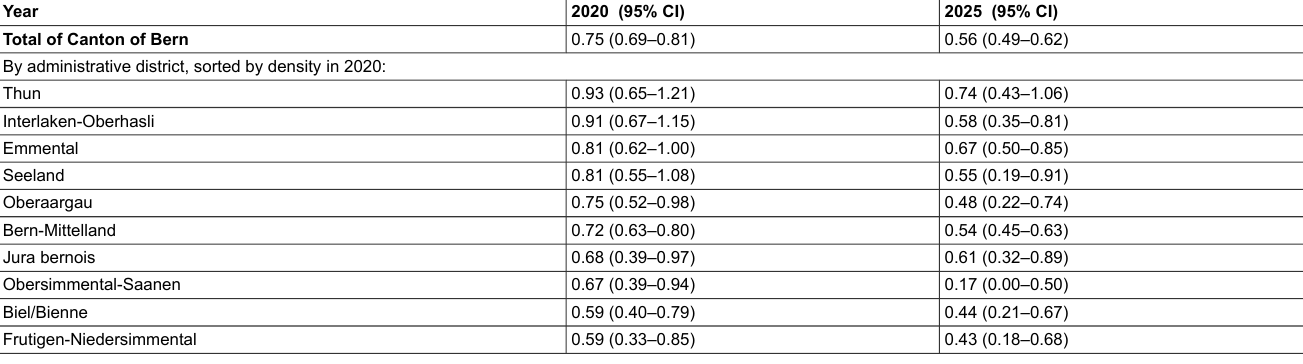
Table 3: Density of primary care physicians (full-time equivalents per 1000 inhabitants) in the Canton of Bern and by administrative district in 2020 and by 2025.